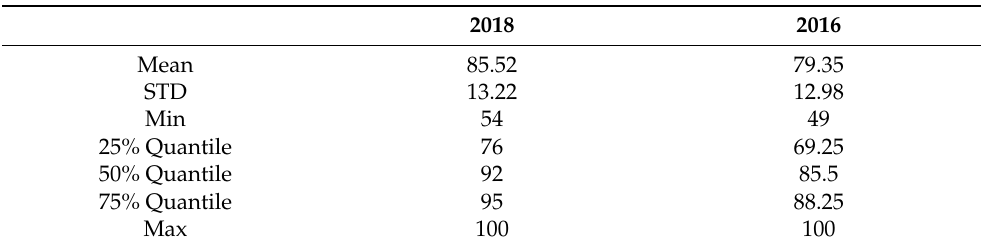
Table 2. Descriptions of relative Google search queries about calories in 2018 (implementation of federal calorie labeling law) and 2016 (comparison